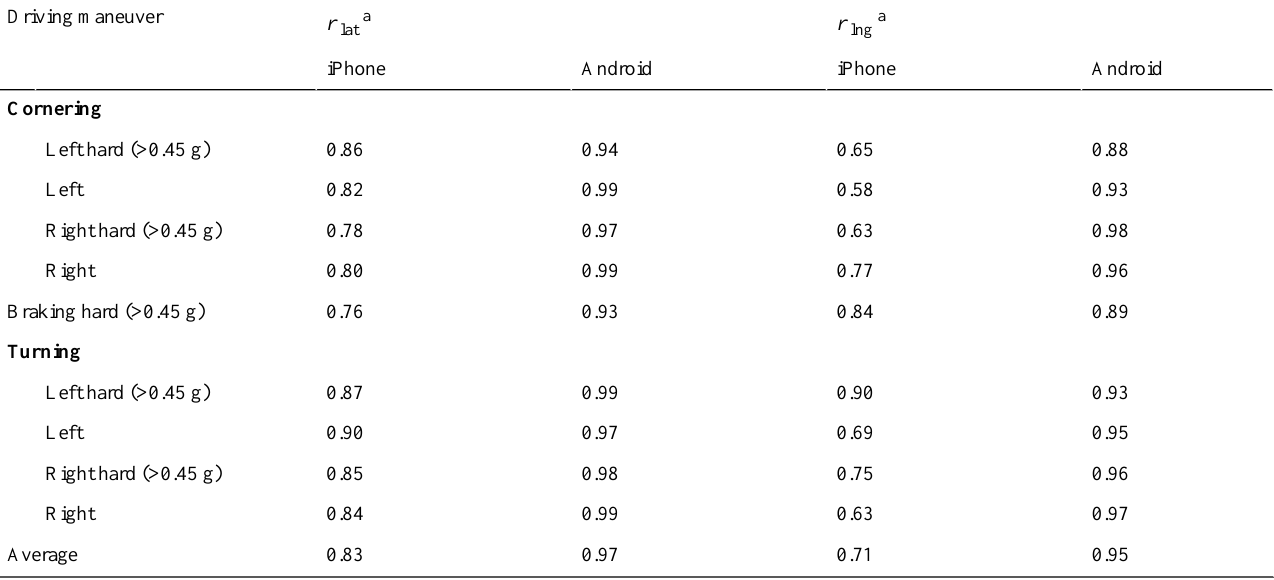
Table 1. Correlation coefficients between data acquisition system (DAS)/iPhone and DAS/Android devices.